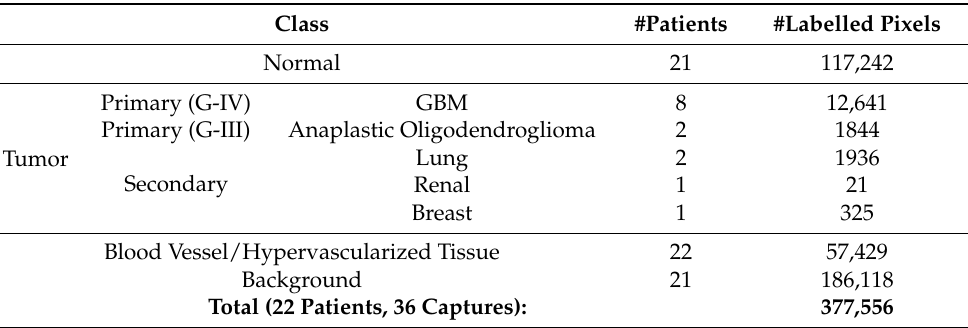
Table 1. Training dataset summary.